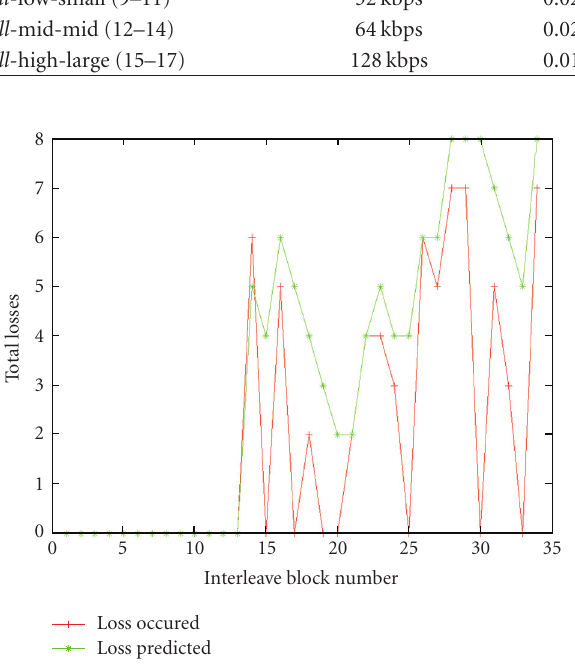
Figure 5: Performance of prediction for “ foreman” sequence at 64kbps, random delay 0.057, bu ff er size 40, packet size 720, span 20, PL rate 30.9%.